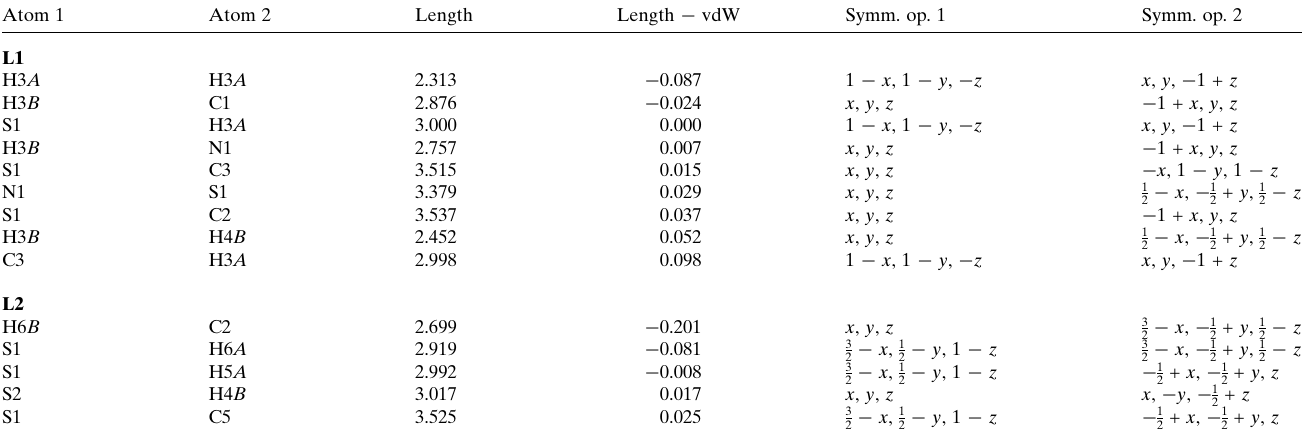
Table 5 Short interatomic contacts a (A˚ ) in L1 and L2 . Atom 1